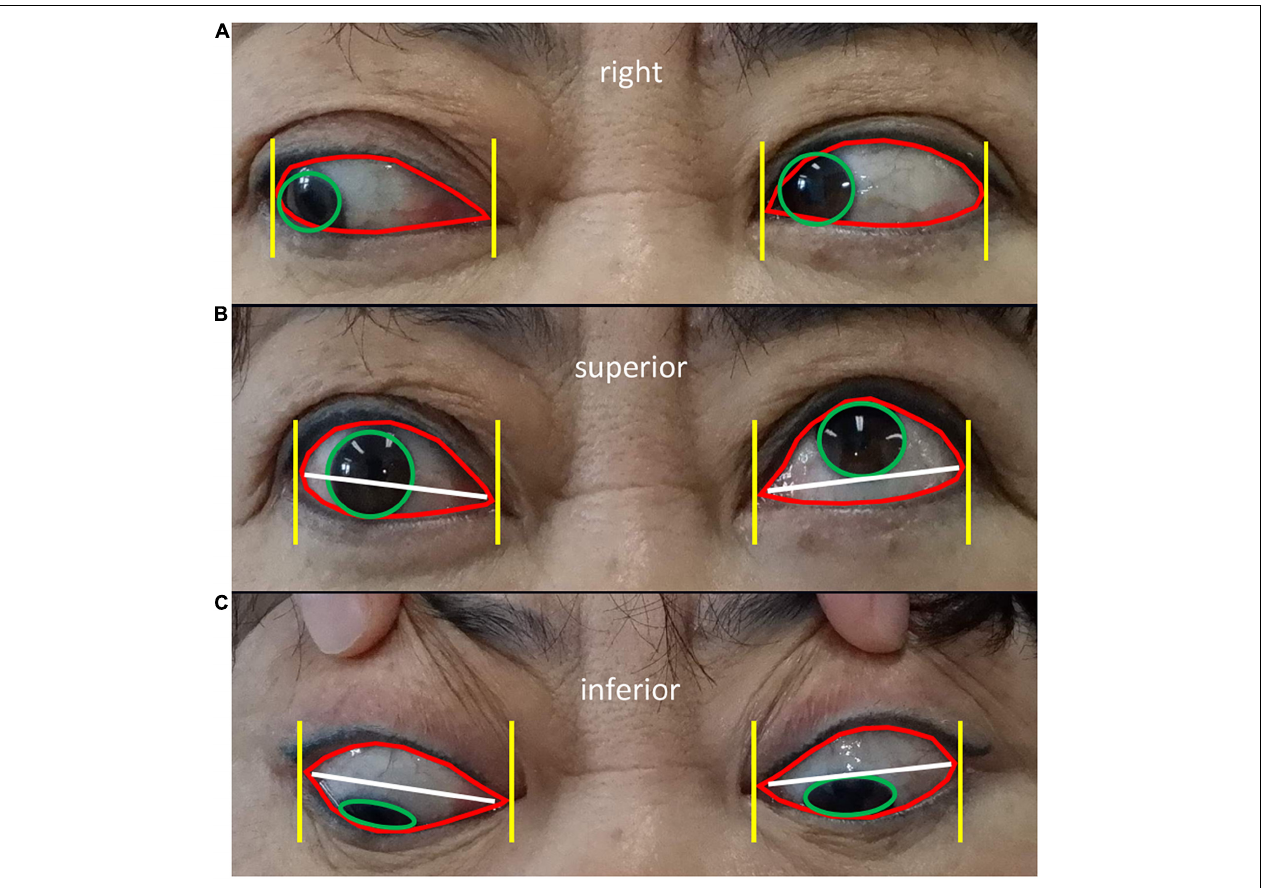
FIGURE 3 | Diagnostic rules of eye movement disorders (A) Diagnostic rules of eye movement disorders. Frontal images of left/righ eye rotation show the cornea (green circle in A ) deviating from the vertex of the canthus (yellow line in A ), indicating impaired eye movement (left eye in A ). When the cornea is tangent to or intersects the vertex of the canthus, no eye movement disorders are present (right eye in A ). Frontal images of superior/inferior eye movement show the cornea (green circle in B,C ) intersecting the line between the inner and outer canthus (white line in B,C ), representing impaired eye movement (right eye in B ). When the cornea is tangent to or separated from the line between the inner and outer canthus, no eye movement disorders are present (left eye in B and both eyes in C